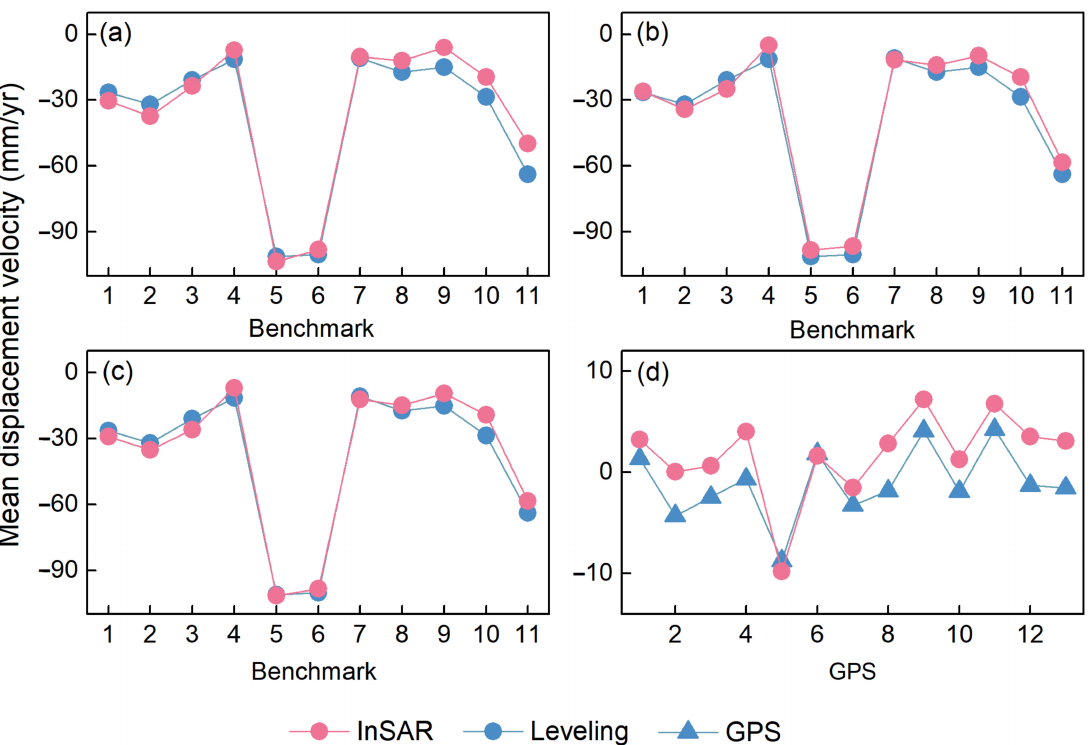
Figure 8. Comparison of the InSAR-derived surface displacement rates with those from GPS and leveling measurements. ( a , b ) Comparison of the ascending and descending InSAR LOS displacements, respectively, with leveling measurements from 2018. ( c ) Comparison of the vertical displacement rates with leveling measurements from 2018. ( d ) Comparison of the east–west displacement rates with GPS measurements from 2017.